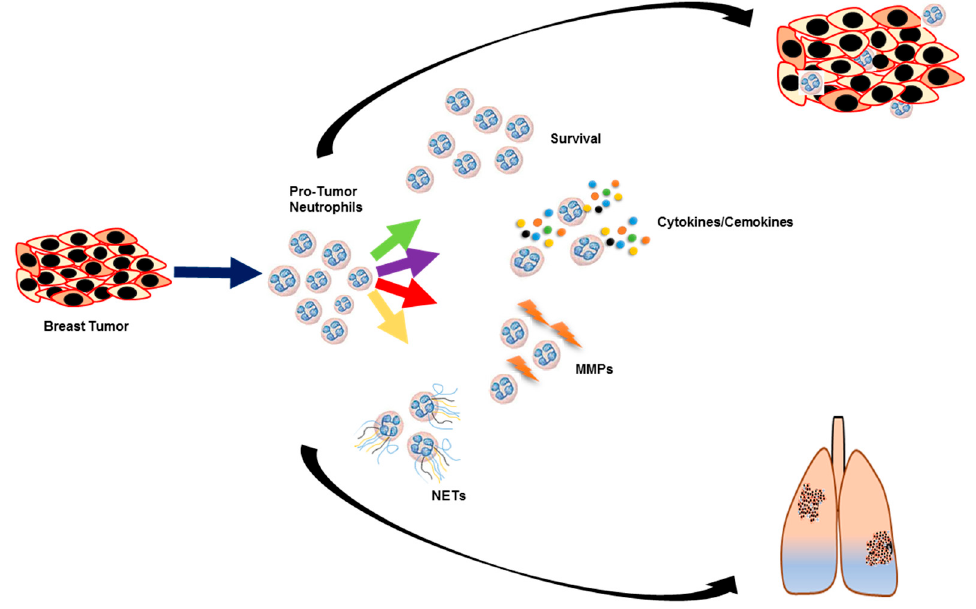
Figure 7. Breast cancer cells induce neutrophils to secrete pro-tumor factors, which aids tumor growth and metastasis. The pictorial diagram showing breast cancer cells enhances pro-tumor factors in neutrophils, which supports tumor growth and metastasis. Breast cancer cells increase the secretion of cytokines and chemokines as well as NET formation in neutrophils. In contrast, chemotherapy-resistant cells further enhanced neutrophil survival and secretion of MMP9, which can result in higher metastasis of chemotherapy-resistant cells.